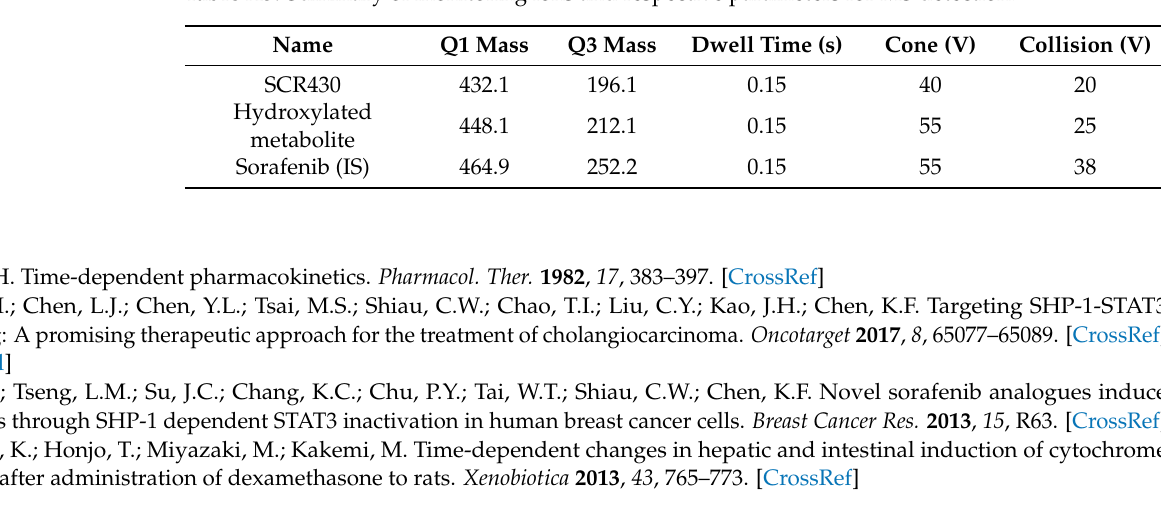
Table A3. Summary of monitoring ions and respective parameters for MS